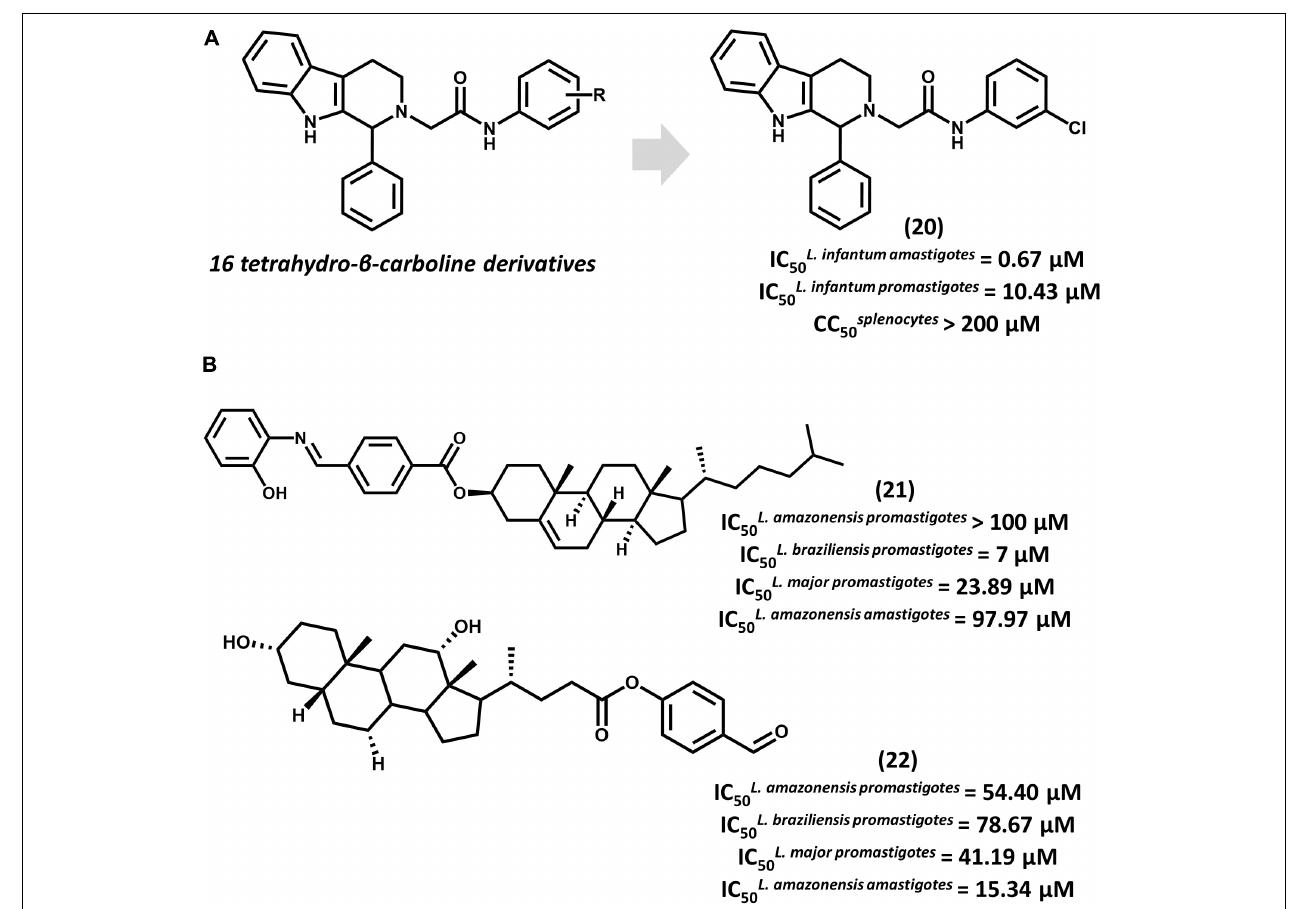
FIGURE 8 | (A) The synthesis of a series of 16 tetrahydro- β -carboline derivatives led to compound 20 having promising in vitro activity against L. infantum promastigotes and amastigotes. (B) Cholesterol and deoxycholic acid derivatives 21 and 22 feature suitable activity against several Leishmania species.